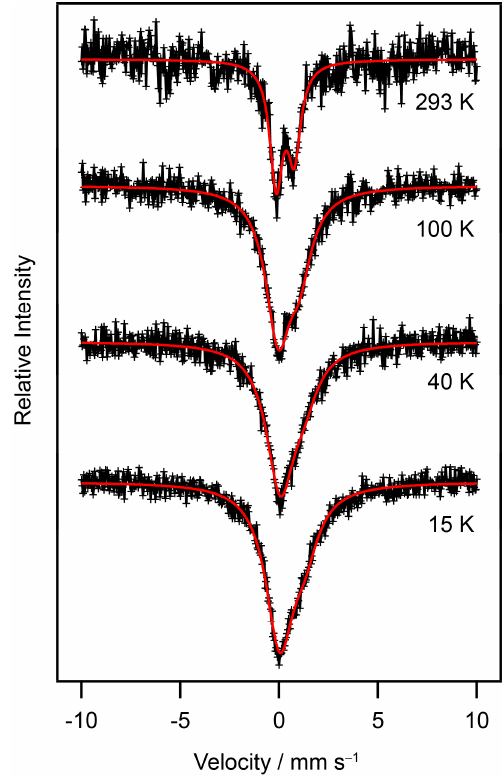
Figure 6. Mössbauer spectra for 1 . Red curves indicate spectra simulated by using the parameters listed in Table 7. Table 7. Temperature variations of Mössbauer parameters for 1 .